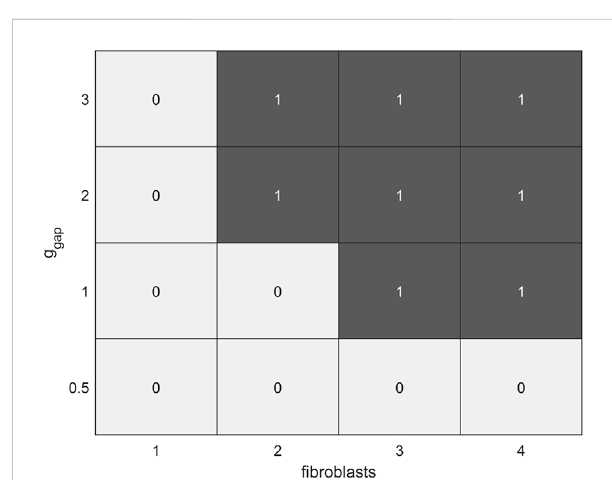
FIGURE 9 Diagram of thedependence ofthe occurrence of EADs (denoted by 0) and extrasystoles (denoted by 1) in the calcium-overloaded cardiomyocyte (twofold increase in i CaL compared to the norm) in model2 onanumberof fi broblasts( n =0, ... ,4)andintercellular fi broblast-to-myocyte conductances ( ɡ gap = 0.5, 1.0, 2.0, 3.0 nS) during isometric contractions at an initial cardiomyocyte length of 90% L max